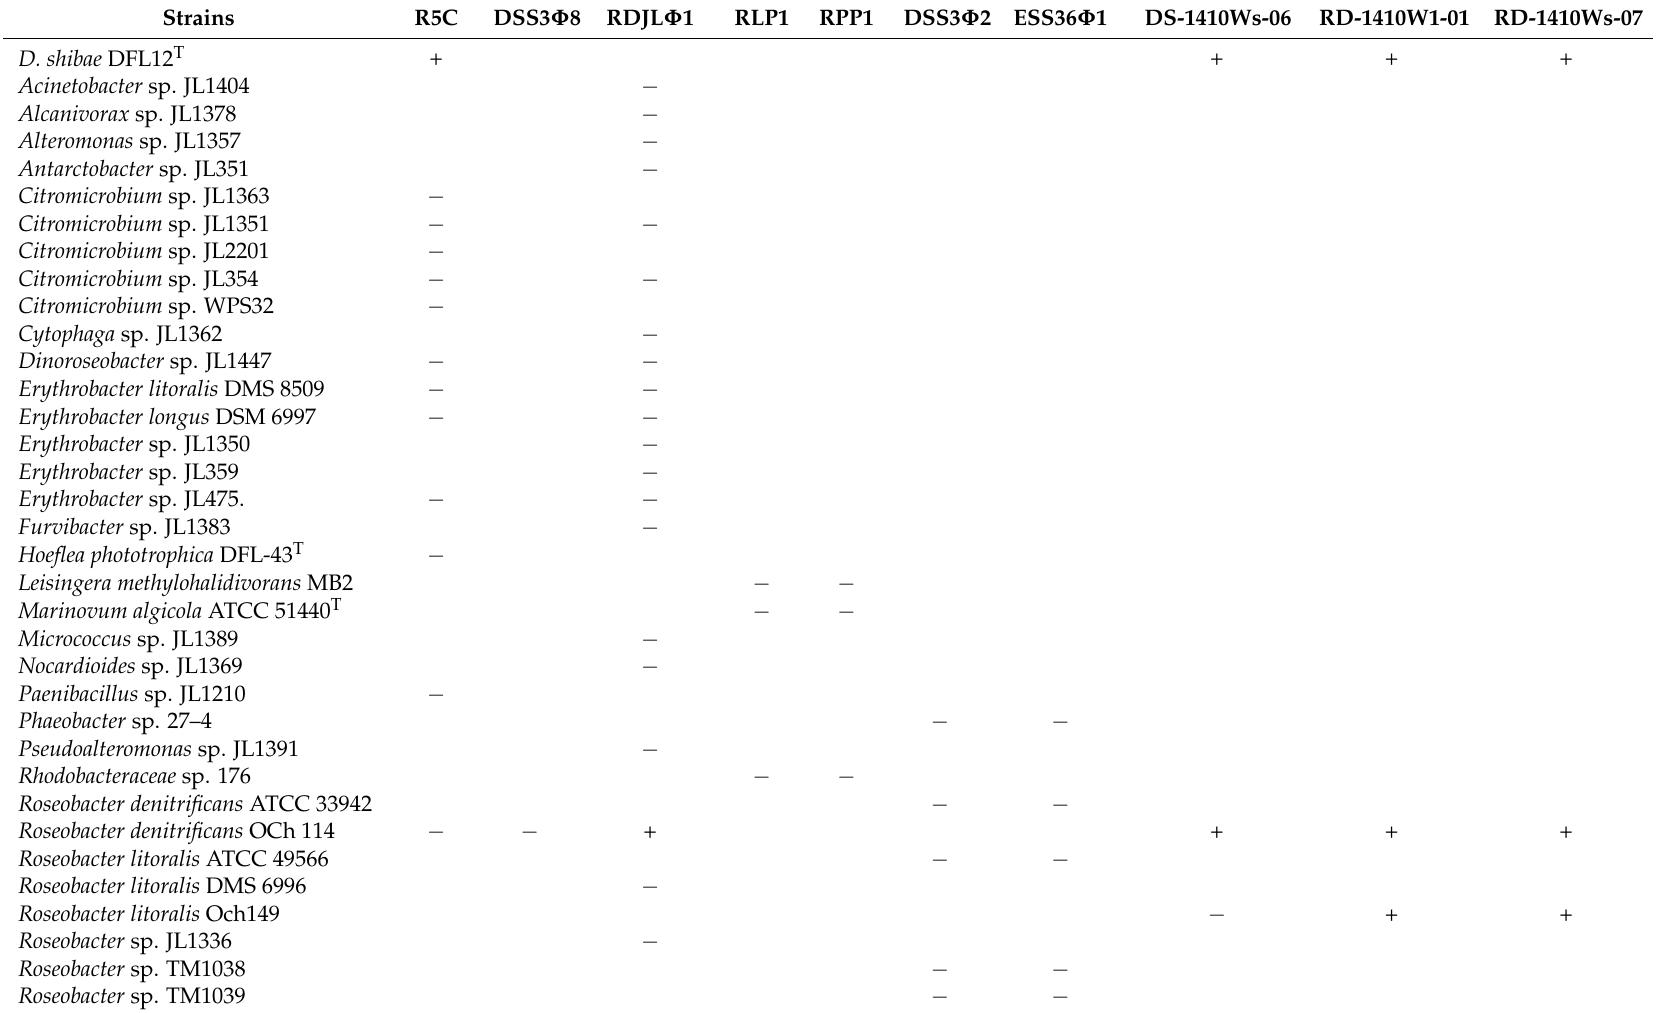
Table 1. Host range of roseophages (+: infected; − :